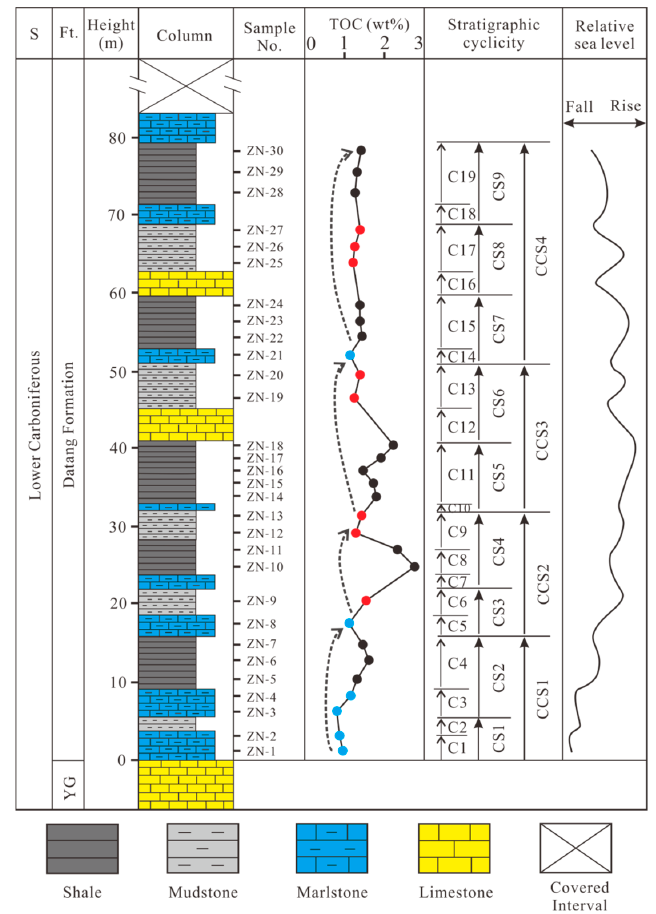
Figure 3. Stratigraphic column of the investigated section. Note the stratigraphic cyclicity and their superimposed patterns and inferred relative sea level fluctuations. Height represents the distance above the base of the Datang Formation. C, CS and CCS represent depositional cycle, cycle set and composite cycle set, respectively. YG stands for Yanguan Formation.